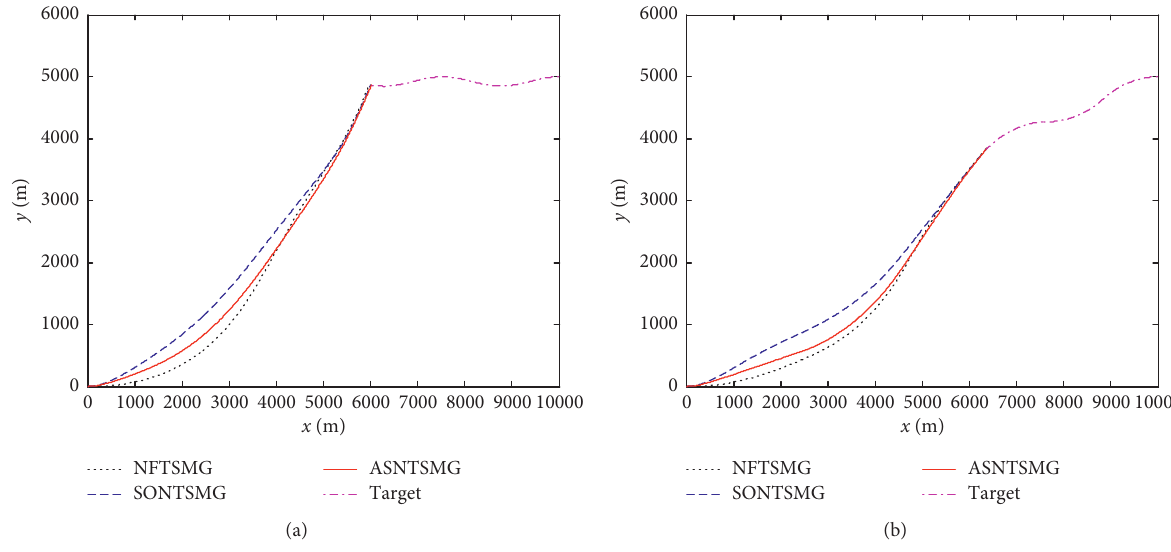
Figure 3: Missile and target motion trajectory. (a) Target cosine motion. (b) Target square wave motion.